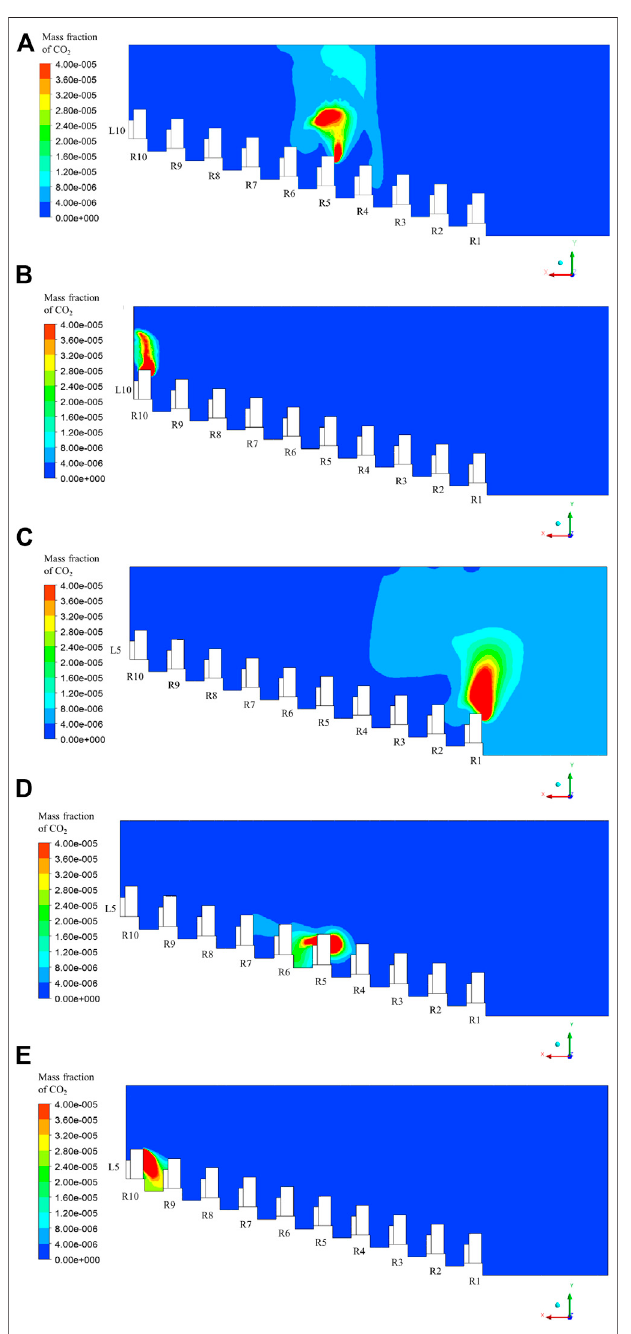
Frontiers in Built Environment |